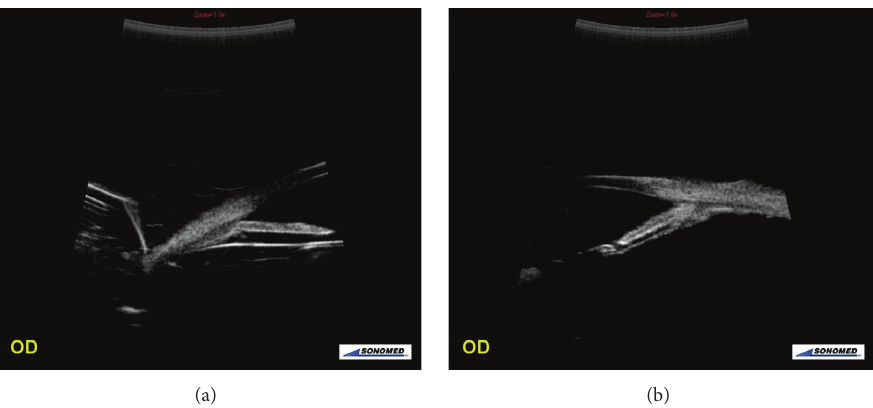
Figure 2: Views of radial section of the angle images from the temporal quadrant. (a) UBM image of an eye with silicone oil used as internal tamponade agent. (b) UBM image of an eye with gas (C 3 F 8 ) used as an internal tamponade